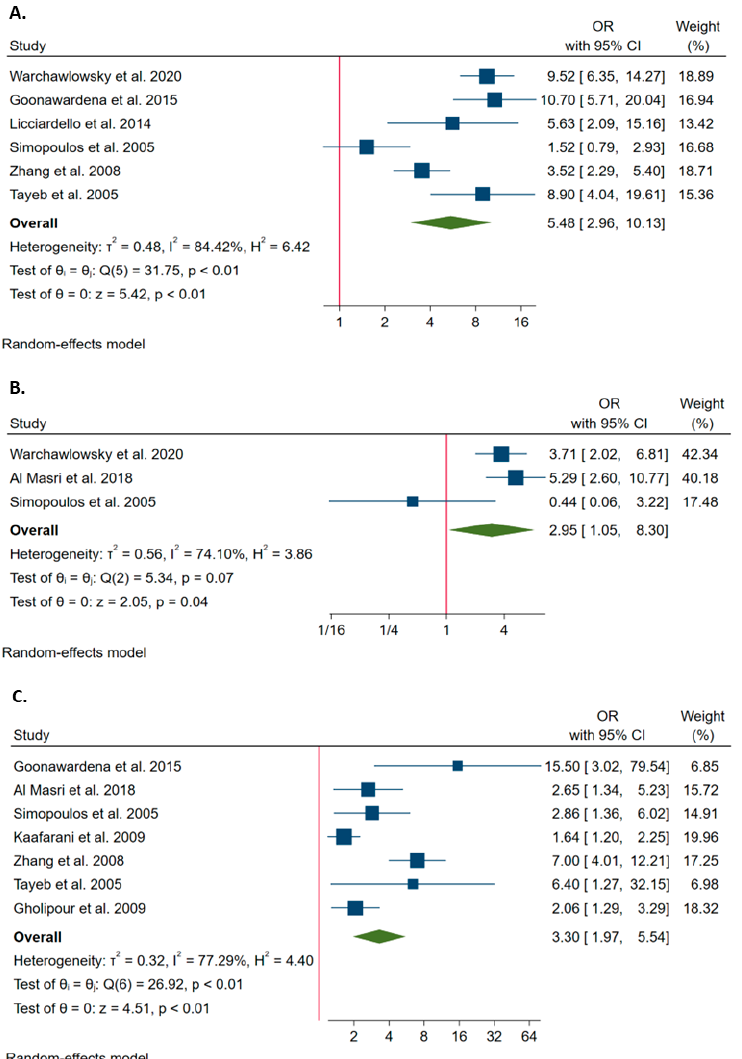
Figure 4. Forest plots of the associations of acute cholecystitis ( A ) [3,22,23,25,28,49], heart disease ( B ) [3,4,23] and previous upper abdominal surgery ( C ) [4,23–25,28,43,49] with the probability of conversion. The graph ( A ) shows the ORs for the comparison between acute and non-acute cholecystitis (reference group). The graph ( B ) shows the ORs for the comparison between patients with heart disease and those without it (reference group). The graph ( C ) shows the ORs for the comparison between patients with previous upper abdominal surgery and those without it (reference group).